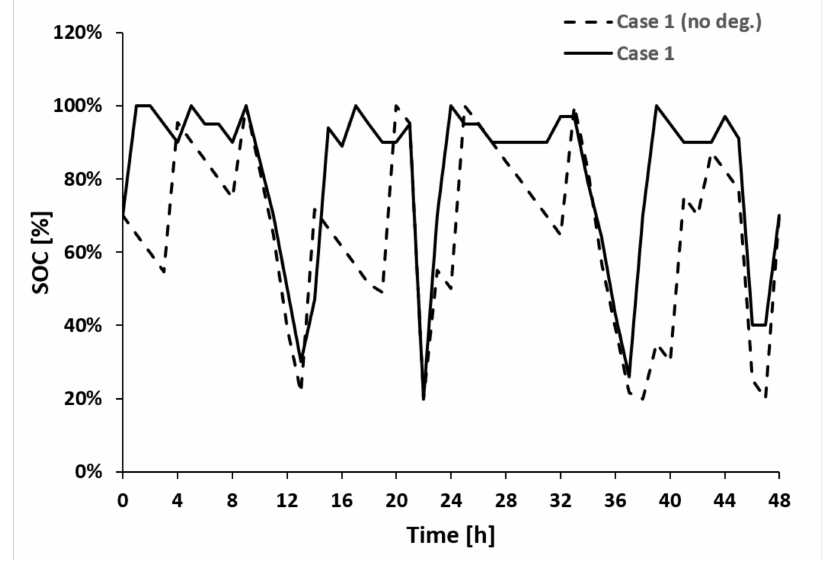
Figure 3. Two-day operation of BESS population with and without